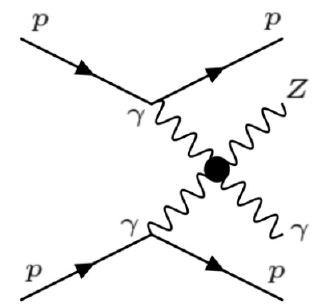
Figure 1 . Anomalous (cid:13)Z production via photon fusion with intact protons in the (cid:12)nal state. An anomalous (cid:13)(cid:13) ! (cid:13)Z reaction is also induced, which is the focus of this work. We (cid:12)nd the unpolarized di(cid:11)erential cross section to be